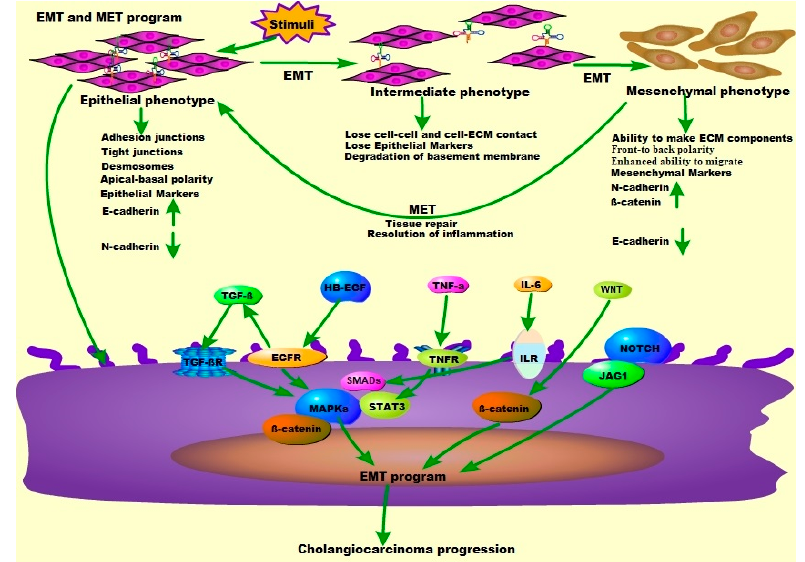
Figure 3. Schematic diagram of the EMT and MET progress in the CCA program . Healthy epithelial cells have a tight junction between the apical-basal polarity and interaction with the basement membrane. These cells express markers of epithelial cell lines such as the adhesive connexin E-cadherin. After stimulation, epithelial cells undergo EMT progression (EMT-induced EMT-TFs results in downregulation), lose cell to cell and cell–ECM connections, lose epithelial markers, express interstitial markers (N-CADHERIN, β -CATENIN), obtain front–back polarity, and enhance migration. During tissue repair or inflammation regression, MET is initiated, and the cells reacquire their epithelial phenotype. Cytokines (TGF- β , TNF- α , and IL-6), tyrosine kinase receptors (EGF, HB-EGF), and their receptors (TGF β R, EGFR, TNFR, and ILR) involved in developmental processes play a key role in the induction of the EMT program by activating intracellular signaling pathways (including MAPKs, IL-6/STAT3, NOTCH/JAG1, and WNT), involved in CCA progression and metastasis. 4. Tumor-Associated Macrophages (TAMs) and Cancer Associated Fibroblasts (CAFs) Macrophages and fibroblasts are the main components of infiltrating stromal cells, called tumor- associated macrophages (TAMs) and cancer-associated fibroblasts (CAFs), respectively. CAFs are a heterogeneous cell population; every tumor type consists of tumor- and tissue-specific CAF subpopulations [114–116]. Different markers have been used to identify these subgroups including α -smooth muscle actin ( α -SMA), fibroblast-specific protein 1 (FSP1), fibroblast activation protein (FAP), and neuron glial antigen-2 (NG2) [116,117]. In human CCA, hepatic stellate cells (HSCs) are thought to be the dominant cellular source of CAFs [118], whilst other studies suggest that CCA- associated CAFs might be derived from portal fibroblasts (PFs) and from bone marrow derived fibrocytes (BMDFs) [119–121]. Activation of CAFs is associated with an invasive phenotype of the tumor in CCA [122]. TAMs and CAFs have also been reported to be involved in tumor progression [56,123,124] as well as in the RAS, MAPK, and MET signaling cascades. On the other hand, TAMs can promote the secretion of tumor growth-promoting factors such as TNF- α , IL6, TGF- β , PDGFR, and VEGFR, among others. These factors can usually act on EMT, promoting tumor growth, and metastasis in CCA [56,125–127]. Cadamuro et al. [56] suggest that CCA cells recruit CAFs by secreting platelet-derived growth factor D (PDGF-D), promoting CCA cell migration through PDGFR- β , RHO-